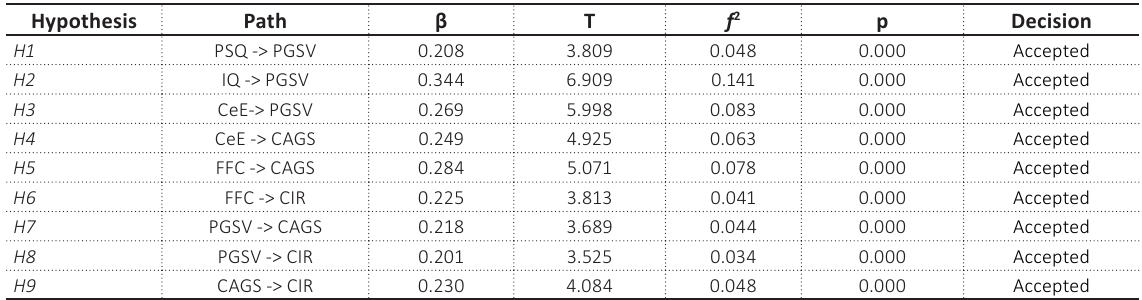
Table 5. Hypotheses